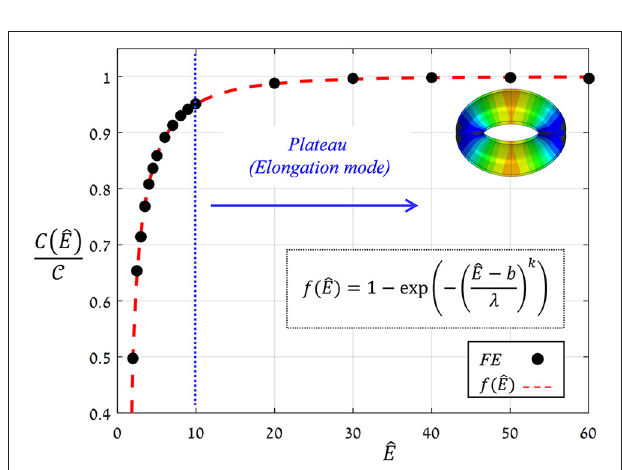
FIGURE 8 | FE results of ˆ δ vs. ˆ P for ˆ E circles, respectively); the corresponding linear fittings are indicated by the dashed lines.